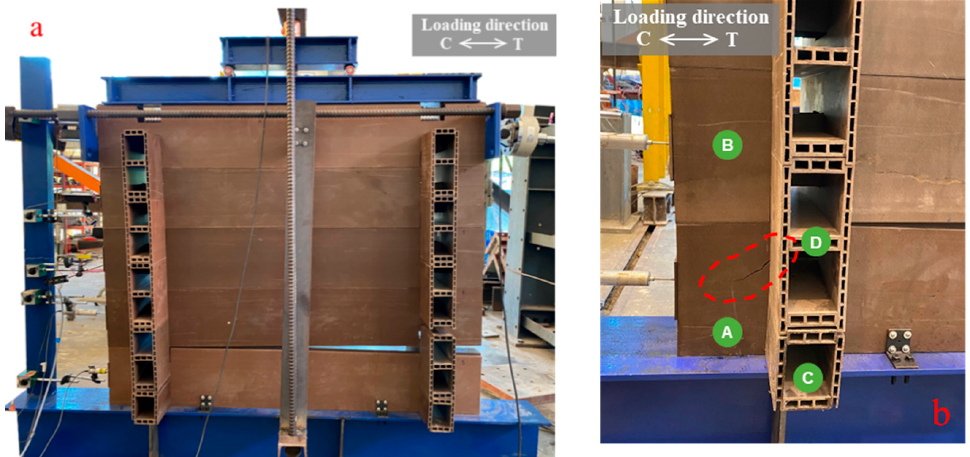
Figure 7. WPVC composite log-wall specimen (W01) under compressive loading: ( a ) Overall deformed shape; ( b ) Tearing of first main log-member (log A).